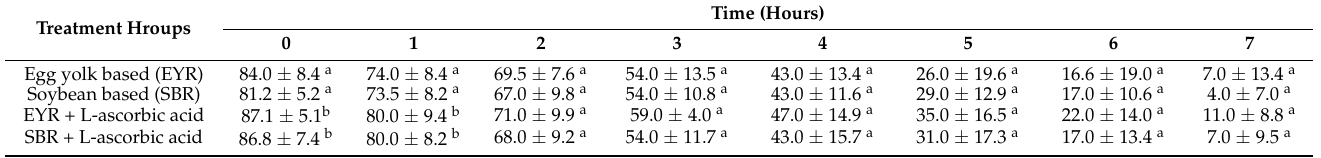
Table 1. Motility (%) of turkey spermatozoa during 7 h of storage at ambient temperature.